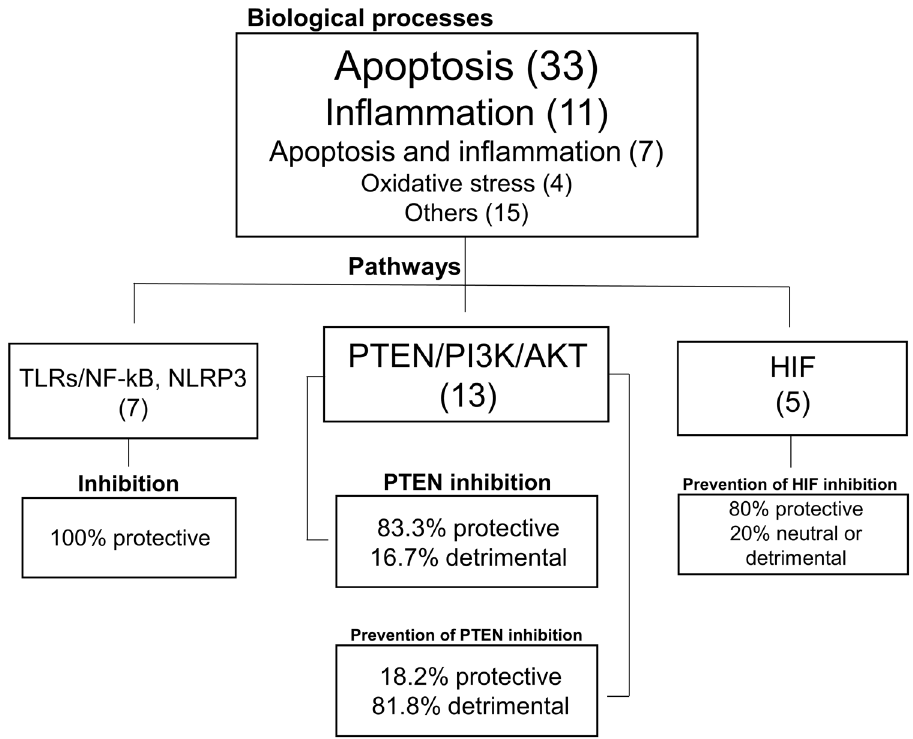
Figure 3. Schematic representation of main biologic processes and signaling pathways in included studies. Apoptosis was the most common biologic process targeted by the interventions and PTEN/PI3K/AKT was the main pathway. AKT: Protein kinase B, HIF: Hypoxia-inducible factor, NF-κB: nuclear factor kappa B, NLRP3: Nod-like receptor family pyrin domain containing 3, PI3K: Phosphoinositide 3-kinase, PTEN: phosphatase and tensin homolog, and TLR: Toll-like receptor.